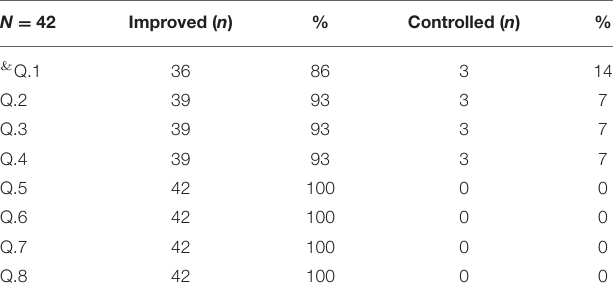
TABLE 3 | Percentage improvement data after the virtual support program.